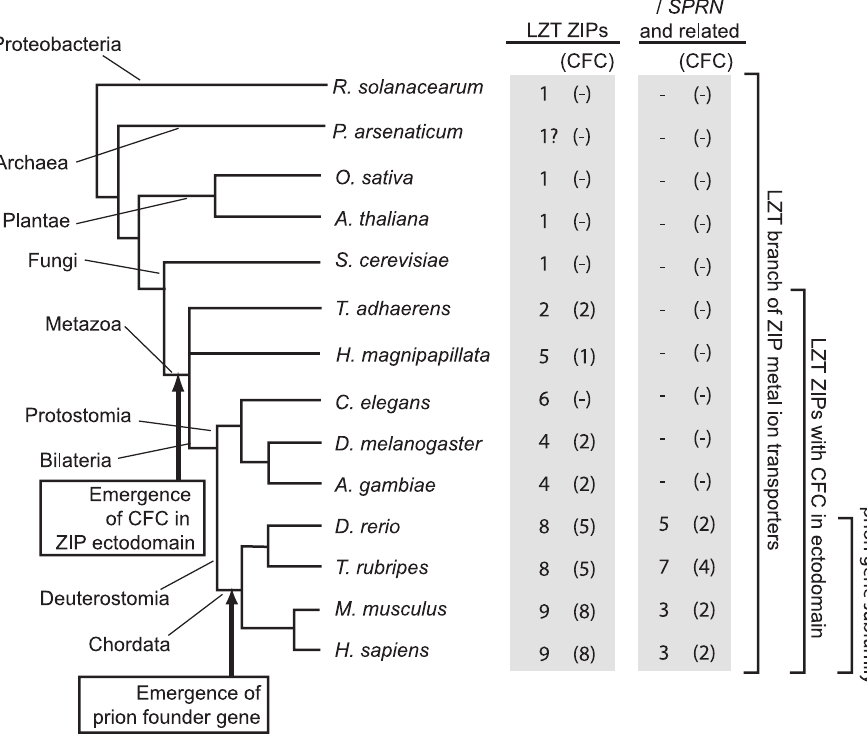
Figure 1. Broad phylogenetic distribution of LIV-1 ZIP metal ion transporters contrasts narrow distribution of prion genes in Chordata lineage. Numbers of LIV-1 ZIP and prion sequences in the selected organisms were extracted from gene data published by the Wellcome Trust Sanger Institute (TreeFam, http://www.treefam.org) and by multiple alignments of ZIP and prion protein sequences. For each organism, the number of the subset of sequences containing a cysteine-flanked core (CFC) domain is indicated in brackets.